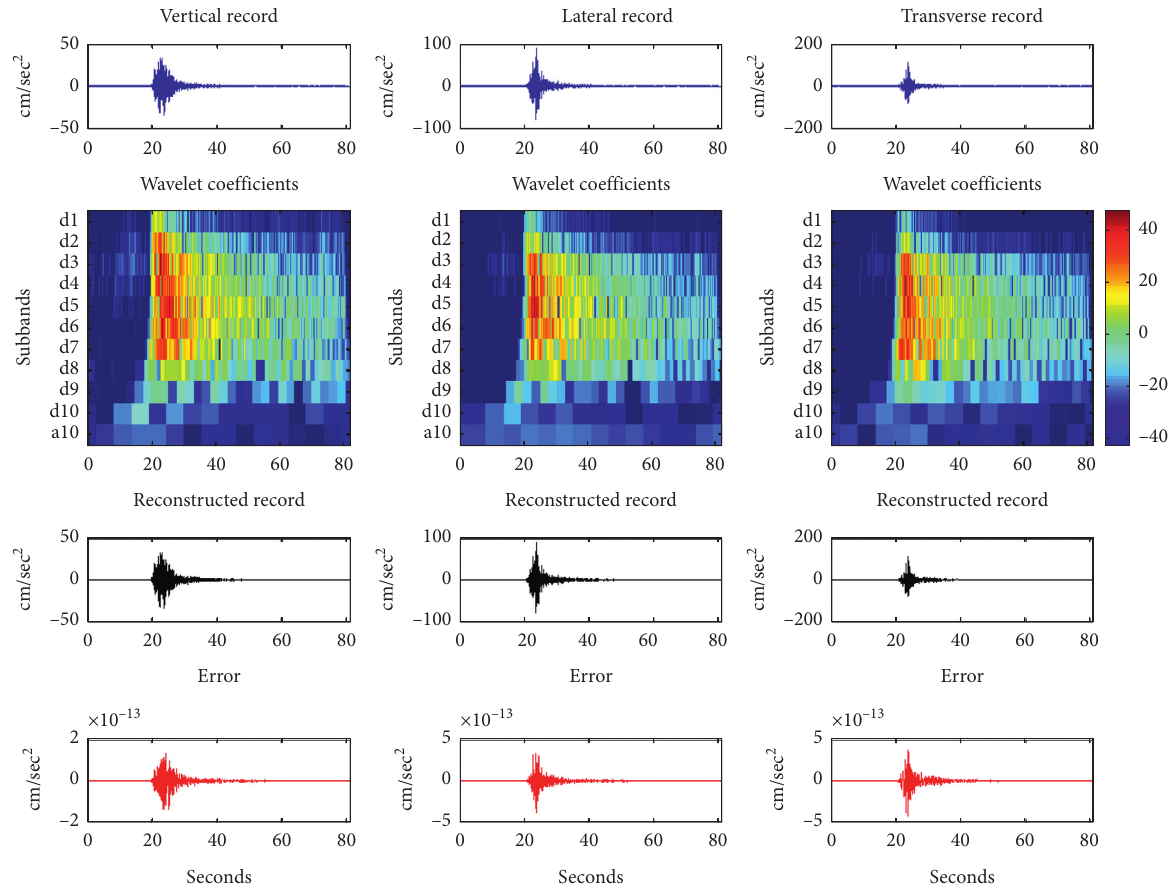
Figure 5: Fast discrete wavelet transform analysis of the Mosha 2020 earthquake accelerograms recorded in Mosha3